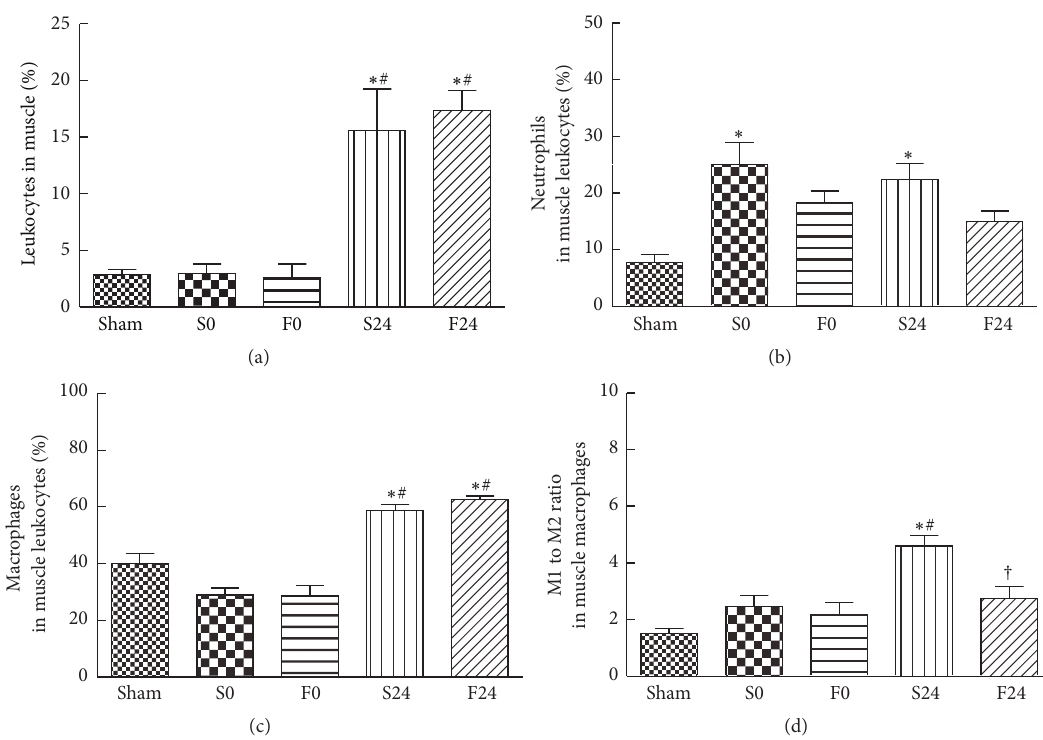
Figure 3: Distribution of (a) white blood cells, (b) neutrophils, (c) macrophages, and (d) M1 to M2 ratio in muscle. Population of neutrophils is presented as percentage of Ly6G in muscle CD45 + cells. Population of macrophages is presented as percentage of F4/80 in CD45 + cells. M1/M2 ratio is calculated based on the percentages of M1 and M2 in muscle CD45 F4/80. The groups are described in the legend of Figure 1. Data are presented as the mean ± SEM ( 𝑛 = 8 ). Differences among groups were analyzed by one-way ANOVA with Tukey’s post hoc test. ∗ Different from the sham group. † Different from the saline (S) group at the same time point. # Different from other time points in the same group ( 𝑝 < 0.05